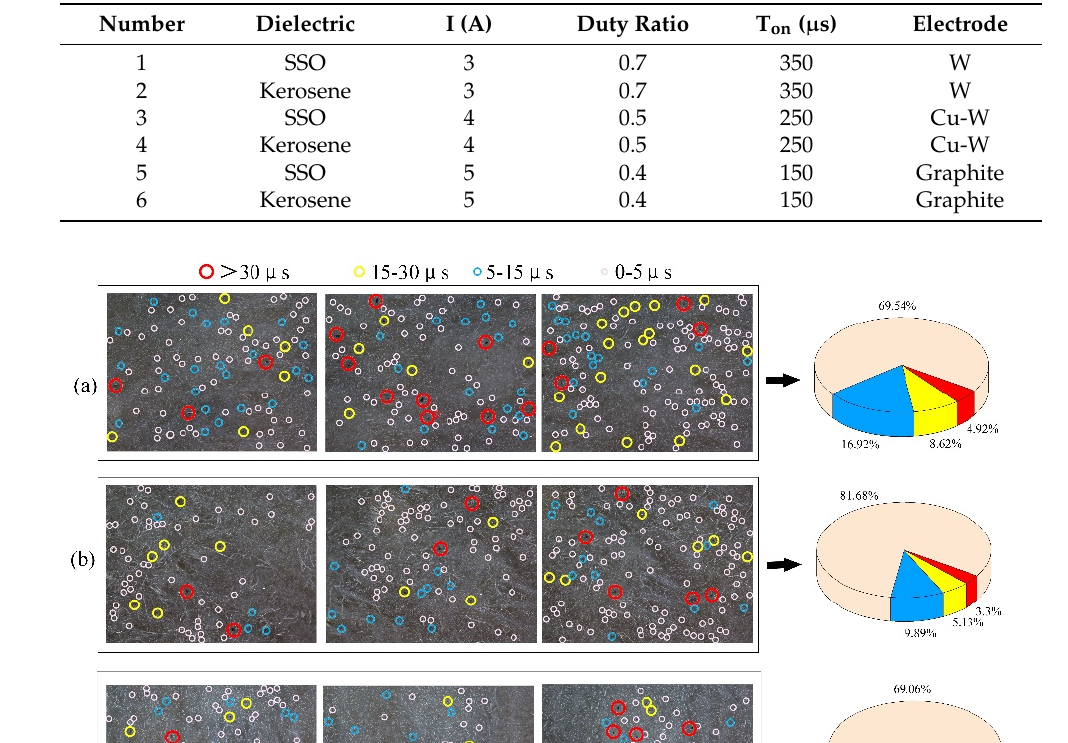
Table 5. Experimental parameters for debris analysis.